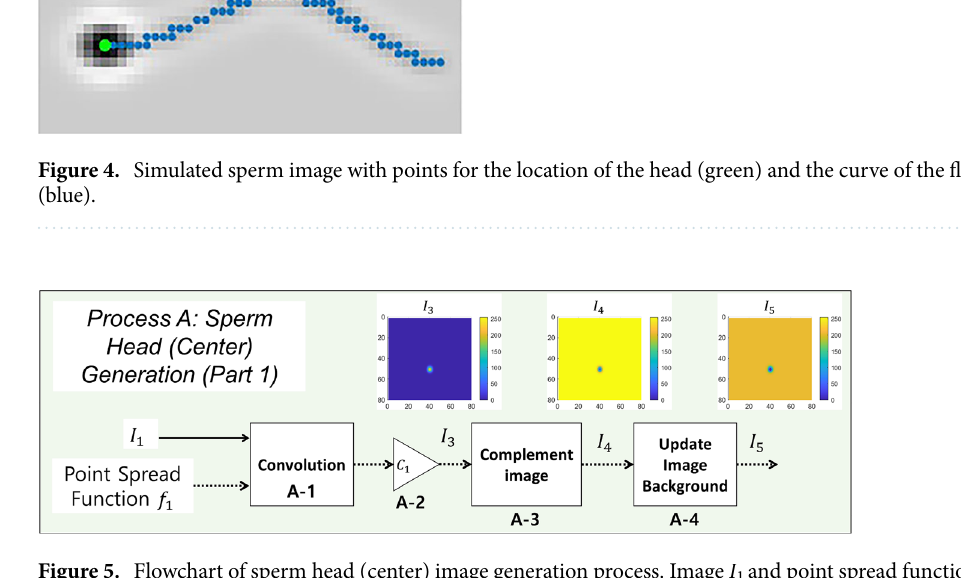
Figure 5. Flowchart of sperm head (center) image generation process. Image I 1 and point spread function f 1 are the inputs. The output is the simulated image of sperm head center I 5 . I 1 and f 1 is convolved and then scaled by C 1 to generate I 3 (Processes A-1 and A-2). The image I 3 is complemented to generate the image I 4 (Process A-3). Lastly, the background is added to image I 4 , generating an image of sperm head center I 5 (Process